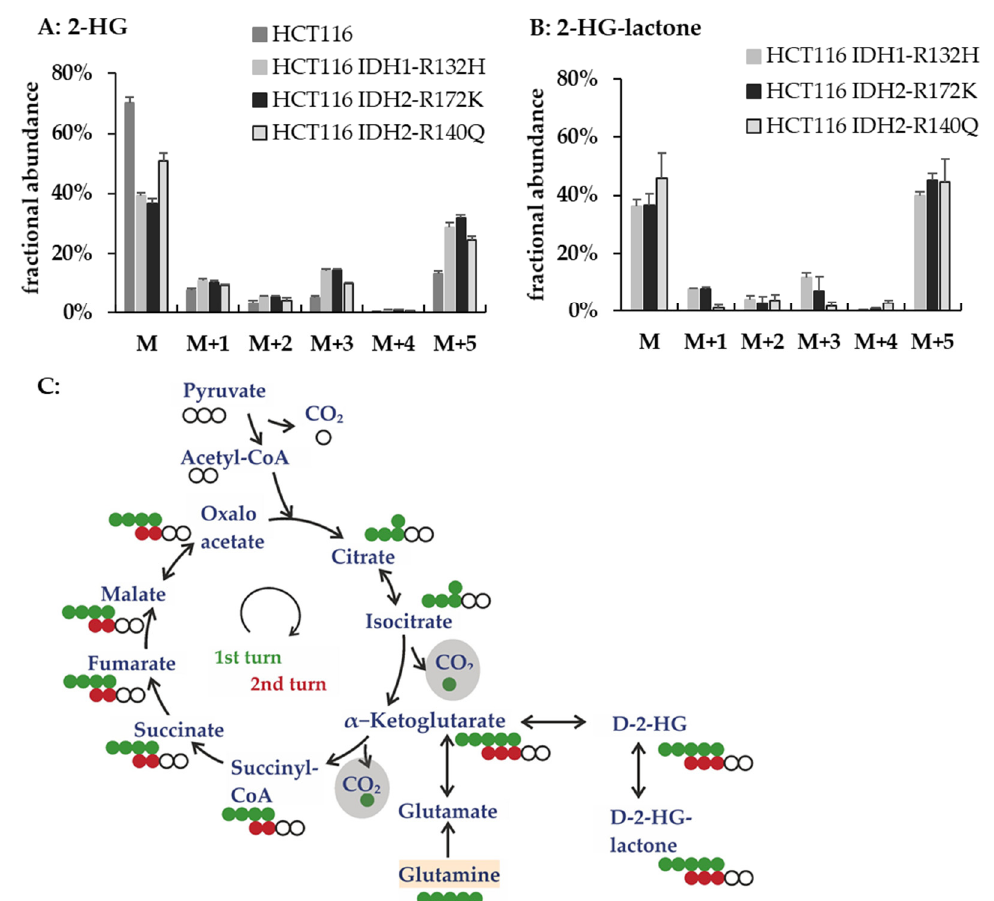
Figure 6. Tracing experiments in IDH1/2 -mutant HCT116 cell lines revealed a high exchange between 2-HG and 2-HG- lactone. Fractional abundance of isotopologues of 2-HG ( A ) and 2-HG-lactone ( B ) for IDH1/2 -mutant HCT116 cells after cultivation with U- 13 C-glutamine for 48 h (M is the unlabeled isotopologue, and M + X indicate the isotopologues with increasing numbers of 13 C). For the parental cell line, no results for 2-HG-lactone are shown because this metabolite was not present in those samples. ( C ) Scheme of TCA-derived metabolites in U- 13 C-glutamine tracer analysis: full circles depict 13 C atoms (green derived directly from U- 13 C-glutamine and red after one turn in the TCA cycle), and open circles indicate 12 C atoms derived from unlabeled precursors, e.g., pyruvate which is the end product of glycolysis. U- 13 C-glutamine was added to the cell culture medium and refueled the TCA by anaplerotic reactions to form α -ketoglutarate. Thus, after each turn in the TCA cycle, two labeled 13 C were lost in form of CO 2 and were substituted by the unlabeled C 2 -body of acetyl-CoA. The expected labeling pattern after one or two cycles through the TCA are shown in green and red, respectively. Hence, one can mainly expect the M + 5/M + 3 of 2-HG in HCT116 cell extracts cultured with 2 mM U- 13